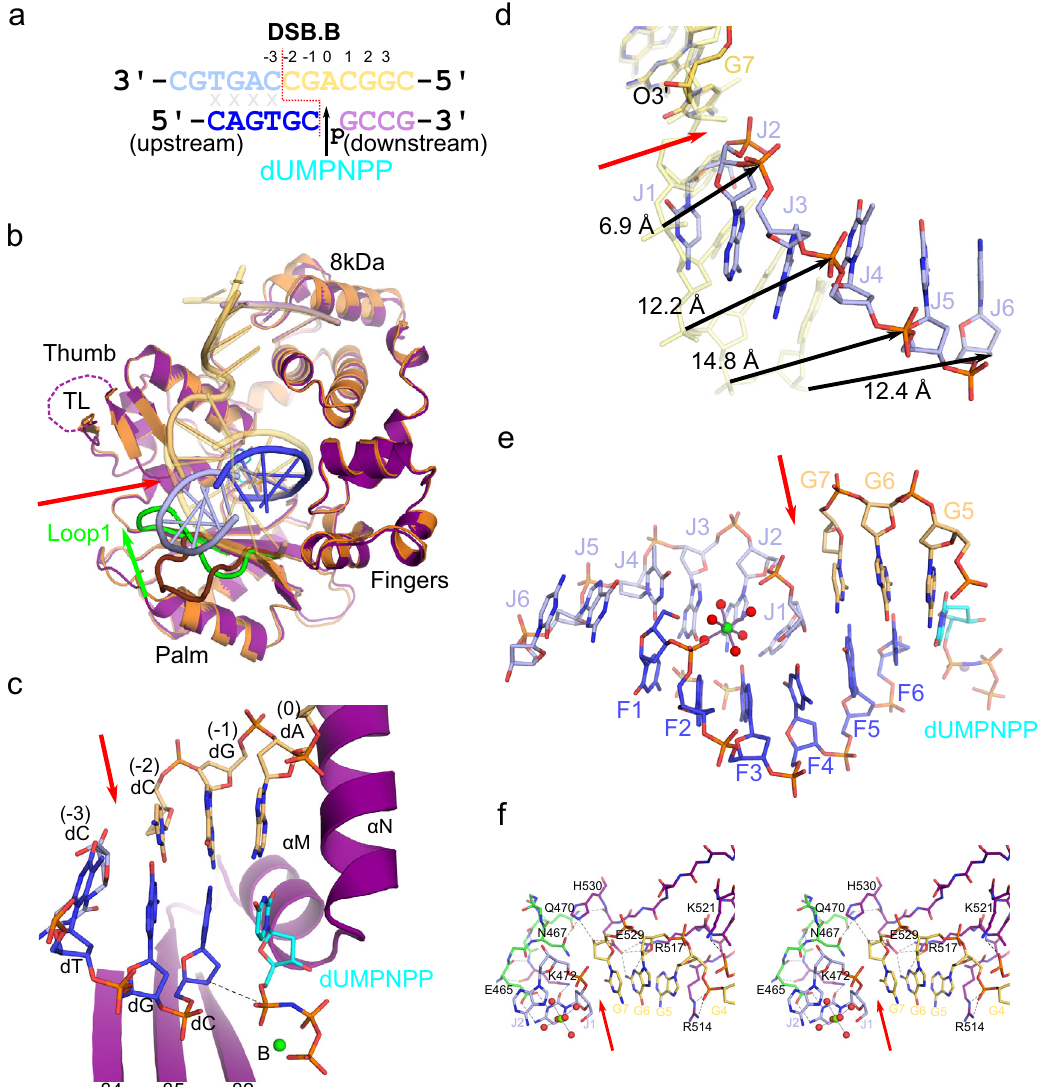
Fig. 6 Pol λ mediates synapsis via primer terminal pairing and accommodates noncanonical structures. a DSB.B substrate co-crystallized with Pol λ catalytic domain (molecule A), with break site indicated by a red dashed line. Upstream (left) primer (blue, chain F) was annealed separately from the downstream (right) template (pale orange, chain G) and primer (lavender, chain H) strands, and synapsis is mediated by the polymerase. Surrogate of upstream template (light blue, chain J) is the 5 ′ -end of the upstream primer from a neighboring molecule, which mispairs (gray x) with the current upstream primer (blue). DSB.B pre-catalytic quaternary complex is formed by addition of nonhydrolyzable incoming dUMPNPP (cyan) nucleotide. b Global superposition of pre-catalytic SSB ternary (protein in orange, DNA in transparent yellow) and DSB.B synaptic (protein in purple, DNA and incoming dUMPNPP colored as in a ) complexes. Positional differences of Loop1 (green) and the DNA template strand between the DSB.B and SSB structures are highlighted. Break site is indicated by a red arrow. c . Structure of the DSB.B synaptic complex bound in the Pol λ active site (protein in purple; DNA and incoming nucleotide colored as in a ). While the metal A site is unoccupied, while the metal B site is fully occupied by a Mg 2 + ion (green sphere). The path between the primer terminal 3 ′ -OH (axial) and the α -phosphate of the incoming dUMPNPP is shown (black dashed line). d Zoomed-in view of the template strand shift in DSB.B (colored as in a ), superimposed with the template strand from the SSB (transparent khaki). e The upstream duplex (primer in blue, upstream template from neighboring molecule in light blue) forms an entirely mispaired duplex, mediated by hydrogen bonding interactions with a hydrated Mg 2 + ion (green, with coordinating waters, red spheres) and alternate conformations of sulfate ions (yellow) from the mother liquor. Expanded views of individual mispairs are displayed in Supplementary Fig. 5. f Stereo diagram of interactions surrounding the break site (red arrow) in the DNA template strand (protein in dark purple, DNA colored as in a ), with hydrogen bonding interactions drawn as black dashed lines. Residues from Loop1 are shown in